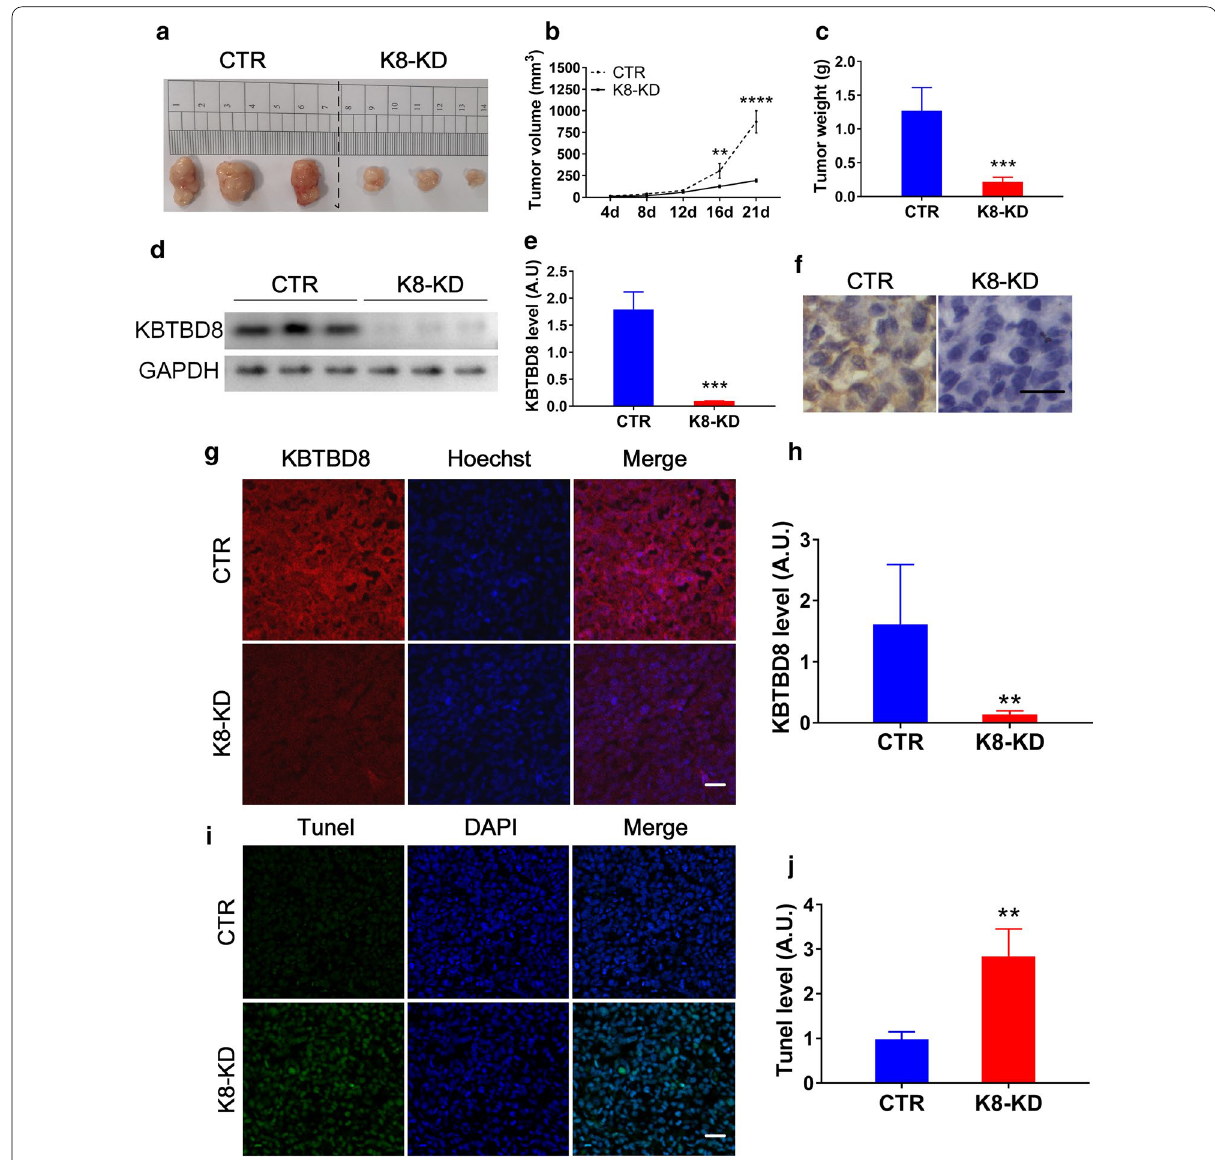
Fig. 7 KBTBD8 knockdown suppressed tumor formation in vivo in A2780 cell xenograft model. a – c In vivo tumor formation assay in A2780 cell xenograft model. Both tumor volume (tumor volume at 21d, CTR vs. K8‑KD, 872.7mm 3 vs. 191.7 mm 3 ) and tumor weight (tumor weight at 21d, CTR vs. K8‑KD, 1.270 g vs. 0.2142 g) were significantly reduced in the KBTBD8‑knockdown A2780 cell xenograft group. d , e Western blot and quantification showed that the KBTBD8 protein level was still significantly lower (KBTBD8 level, CTR vs. K8‑KD, 1.790 vs. 0.09559)